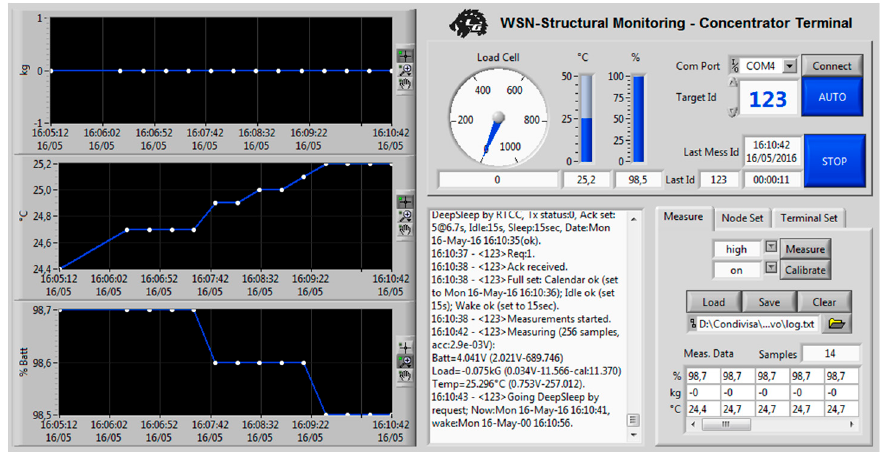
Figure 3. The hub terminal.